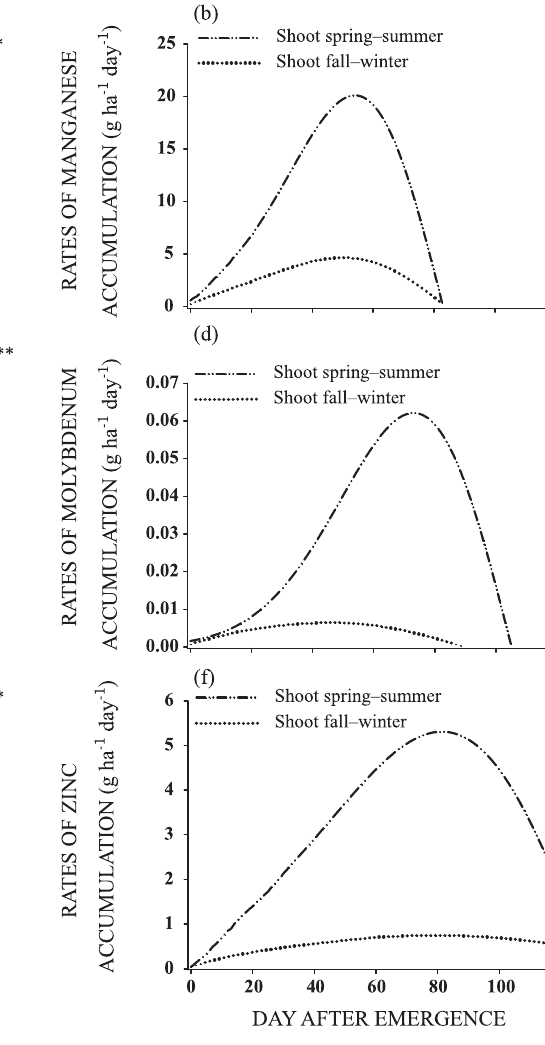
Figure 6. accumulation and accumulation rates of manganese (a and b), molybdenum (c and d) and zinc (e and f) in shoot of the castor bean hybrid Lyra in the 2005/2006 spring-summer and 2006 fall-winter growing seasons. ** and * are: significant at p ≤ 0.01 and p ≤ 0.05 by the F